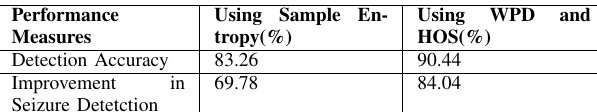
Fig. 9. 4th level decomposition coefficients TABLE III C LASSIFICATION P ERFORMANCE M